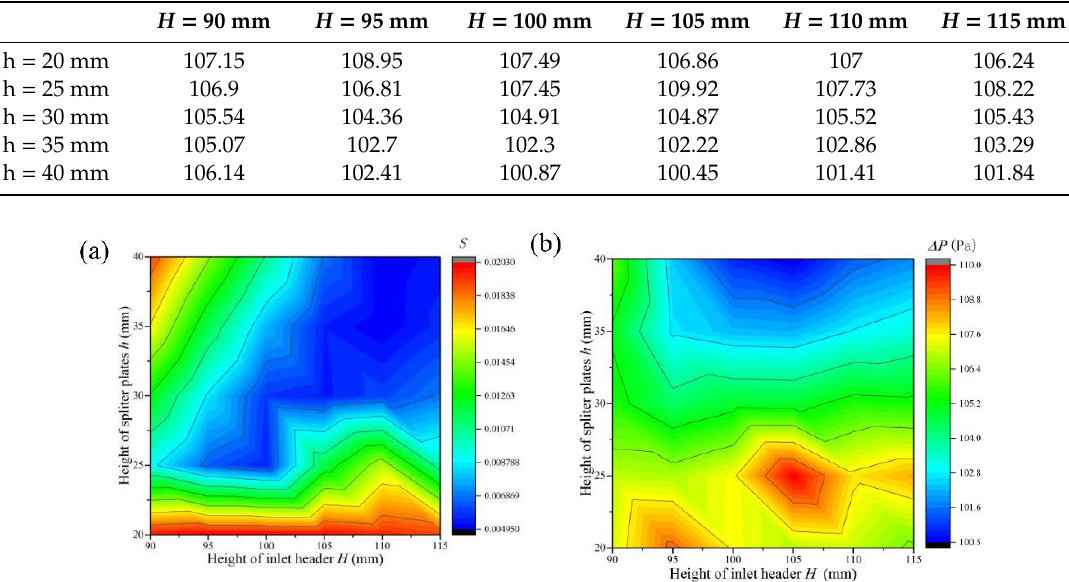
Table 2. Pressure drop ∆ p (Pa) under different combinations of inlet header height H and splitter plate height h.